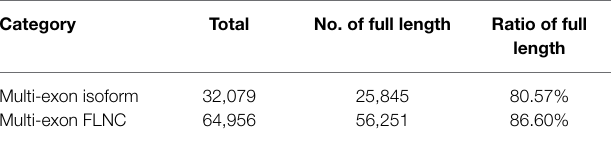
TABLE 3 | Evaluation of full-length transcripts in the PacBio data set.